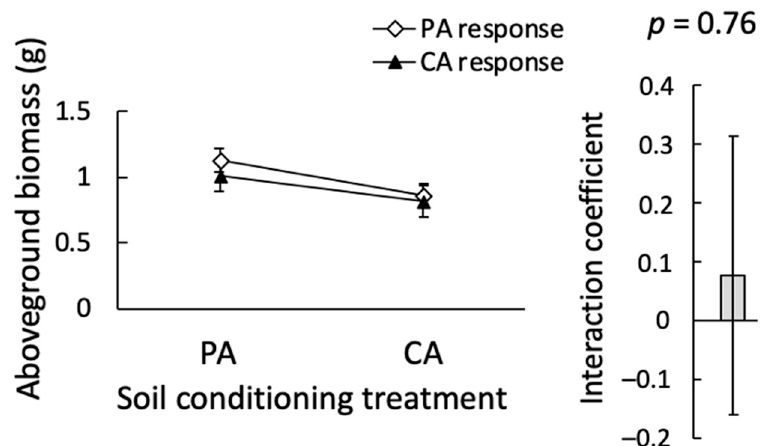
Figure 4. Feedback between Phalaris arundinacea (PA) and Cirsium arvense (CA). These species experience neutral feedback. Neither species is significantly affected by soil conditioning treatment although both P. arundinacea and C. arvense grow slightly better in soil conditioned by P. arundinacea . The inset shows the interaction coefficient between these species, which does not differ significantly from zero ( p = 0.76), also indicative of neutral feedback. Bars indicate ± SE.